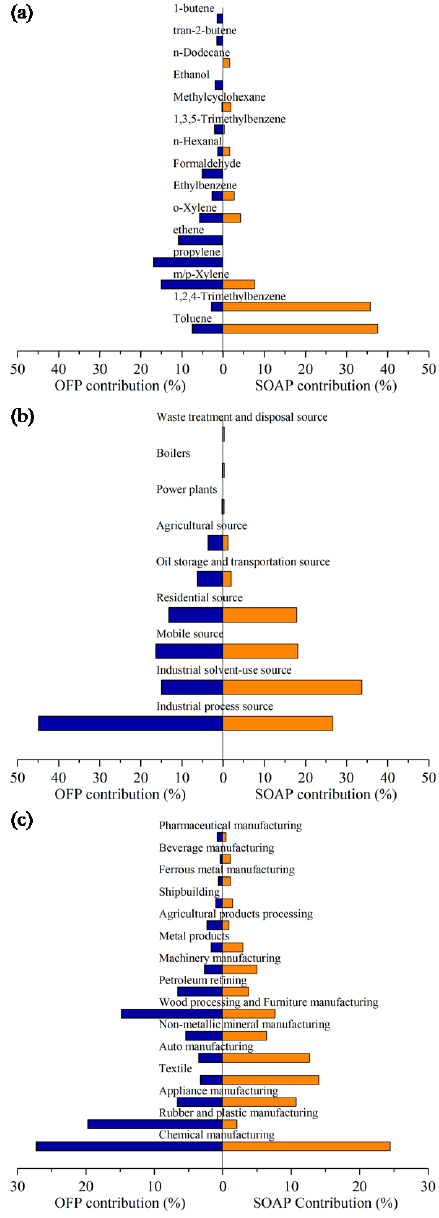
Figure 10. OFP and SOAP formation potentials for different vari- ables: (a) NMVOC species, (b) emission sources, and (c) industrial